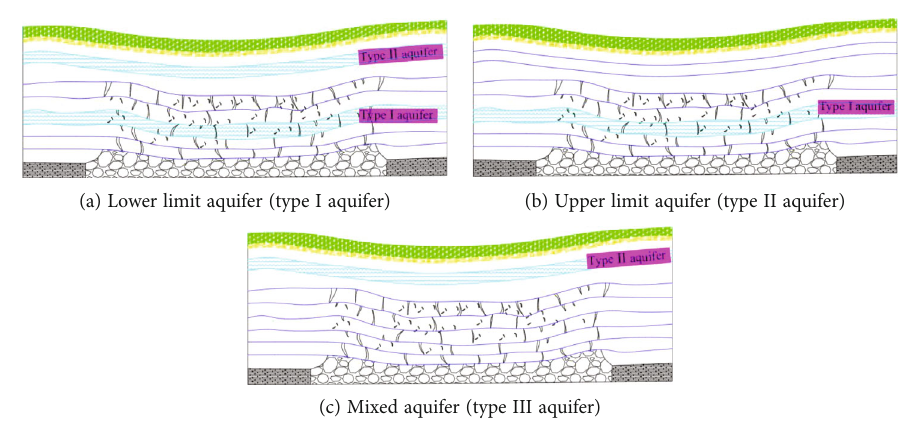
Figure 1: Overview of study area.